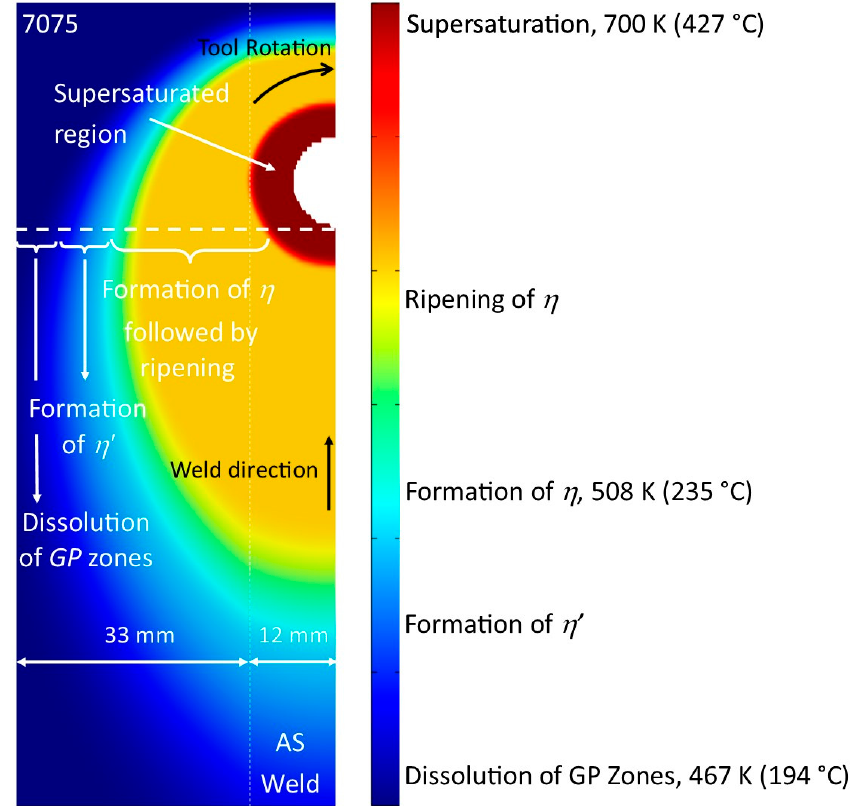
Figure 4. Phase transformation map for 7075 representatively shown on the advancing side. Regions of phase transformations associated with GP zones and the η ’/ η phases are annotated.